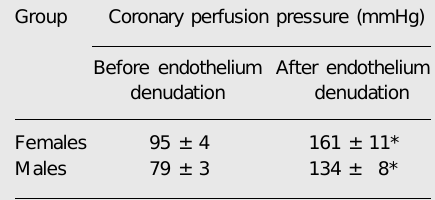
Table 1. Coronary perfusion pressure of isolated hearts from female and male rats before and